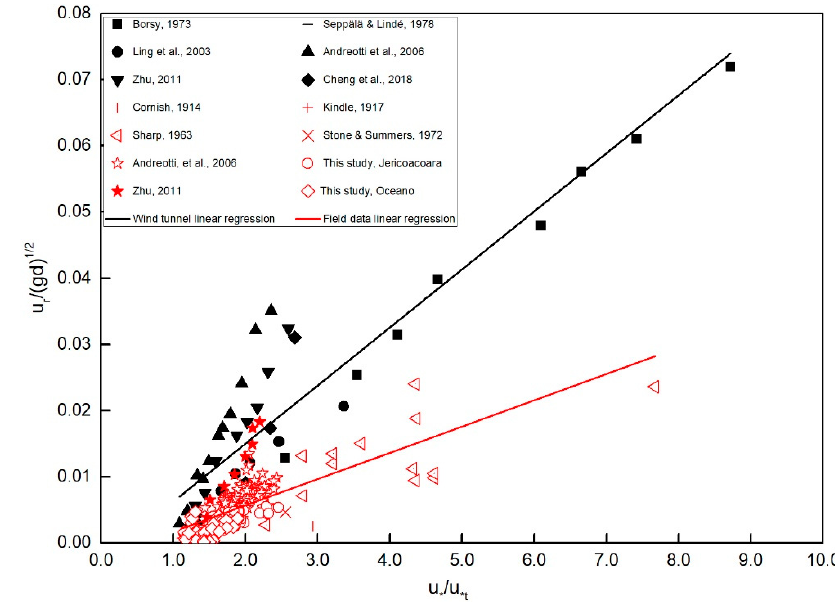
Figure 3. Dimensionless migration rates for equilibrium ripples as a function of dimensionless shear velocity, segregated as wind tunnel (black symbols: n = 41; R 2 = 0.85) or field data (red symbols: n = 174; R 2 = 0.52).